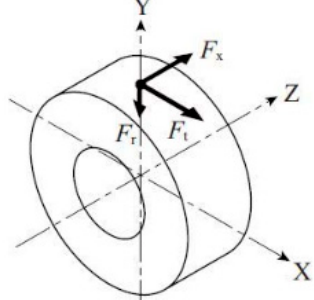
F t : Tangential force that acts in the direction of the x-axis F x : The axial force that acts in the direction of the z-axis F r : Radial force that acts in the direction of the y-axis. Figure 10. The forces that act on the teeth gear when they mesh.